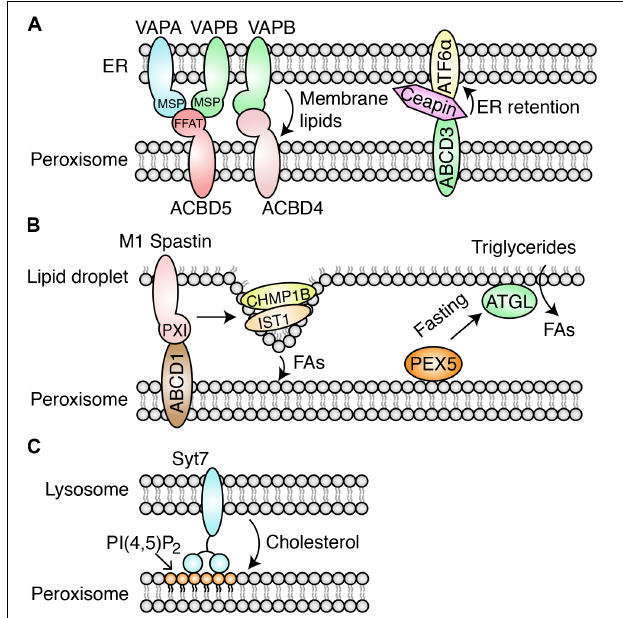
FIGURE 1 | Identified PO-MCSs in mammalian cells. (A) PO-ER-MCS. At the MCS, the FFAT motif in ACBD5 interacts with the MSP domain in VAPA/B. The ACBD4/5-VAPA/B-tethered MCS facilitates lipid transfer from the ER to peroxisomes and promotes the expansion of peroxisomal membranes. Ceapin sequesters ATF6 α at the ER by tethering ATF6 α to peroxisomal ABCD3. (B) PO-LD-MCS. M1 Spastin interacts with ABCD1 through the peroxisome-interacting (PXI) region. M1 Spastin recruits the ESCRT-III subunits IST1 and CHMP1B to the surface of LDs to promote FA trafficking through the MCS. ATGL is recruited to the MCS by PEX5 in response to fasting stress, promoting lipolysis of triglycerides stored in LDs. (C) PO-Lyso-MCS mediated by PI(4,5)P 2 and Syt7. This MCS facilitates cholesterol trafficking from lysosomes to peroxisomes.